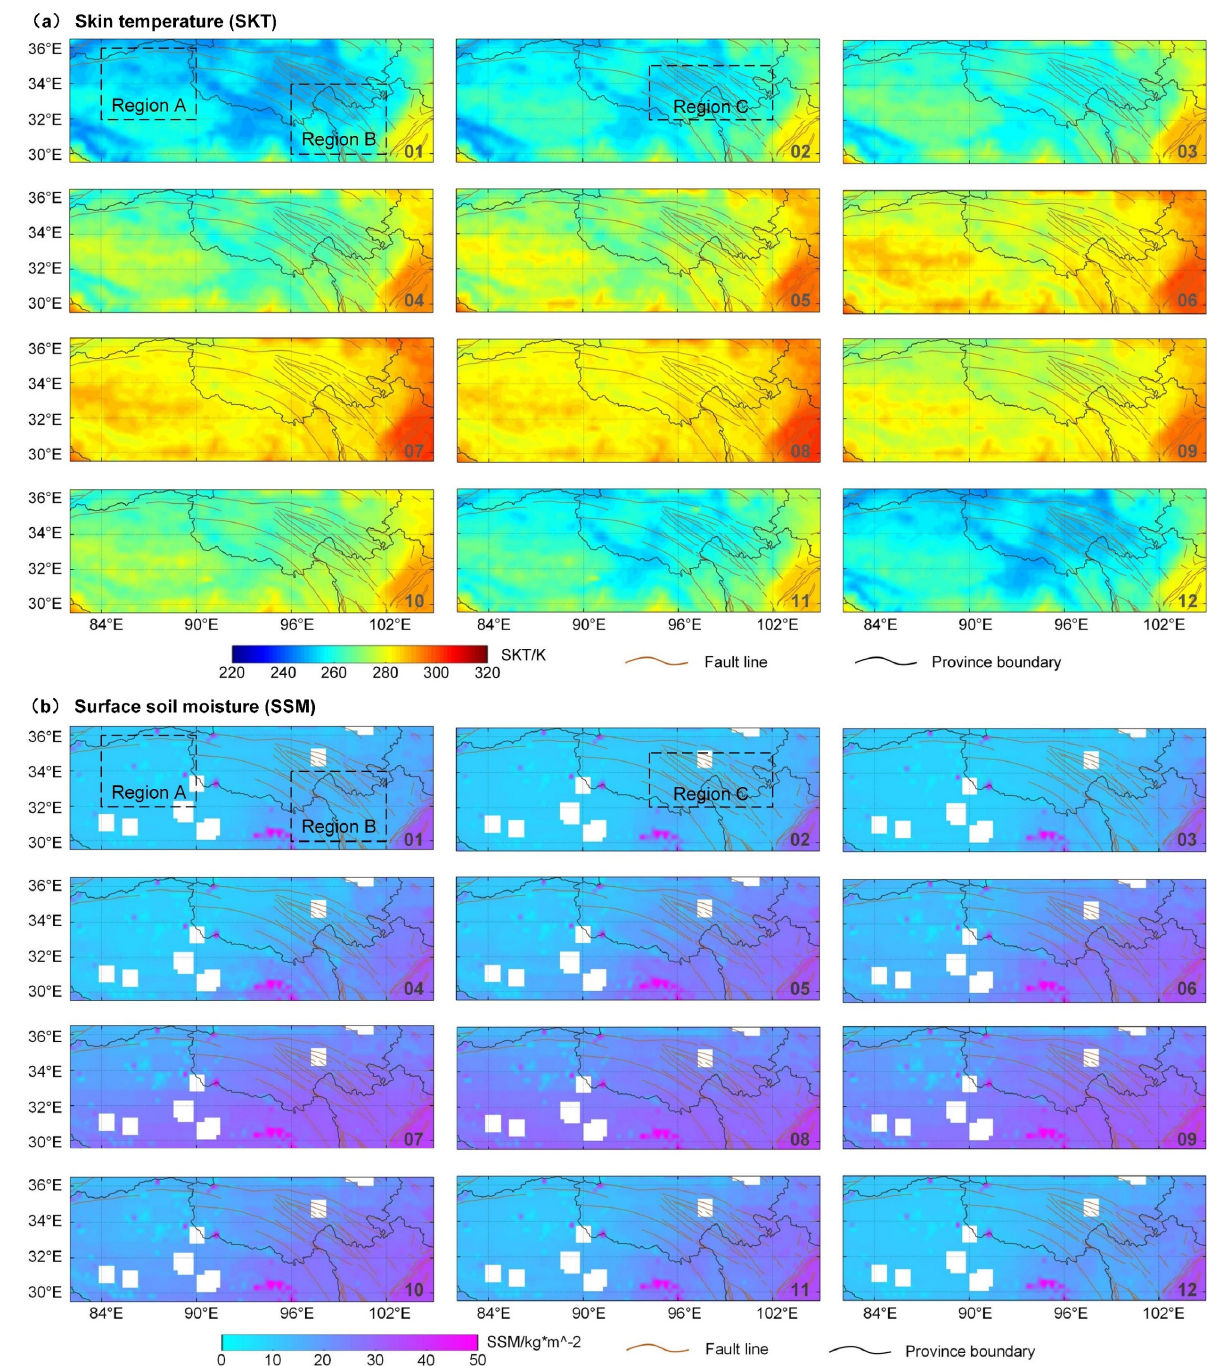
Figure 4. Monthly mean SKT ( a ) and SSM ( b ) in the study area. Region A, B and C represent the plateau area, the mountainous area and the boundary area of the provinces, respectively.